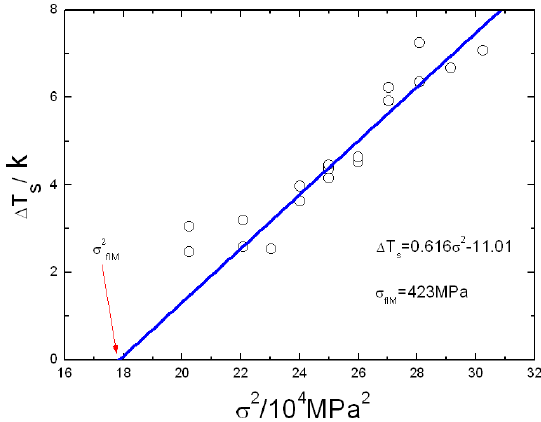
Figure 5: Fatigue limit stress by the infrared thermographic method.